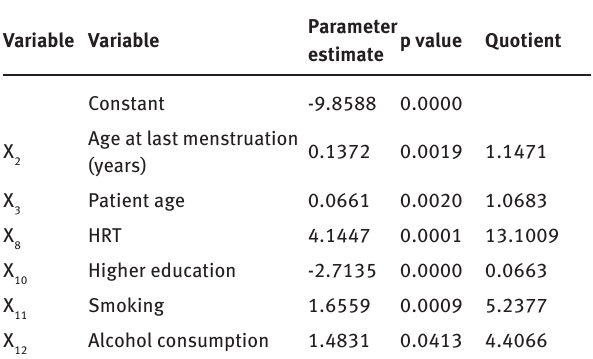
Table 13: Evaluation of the parameters of the logit